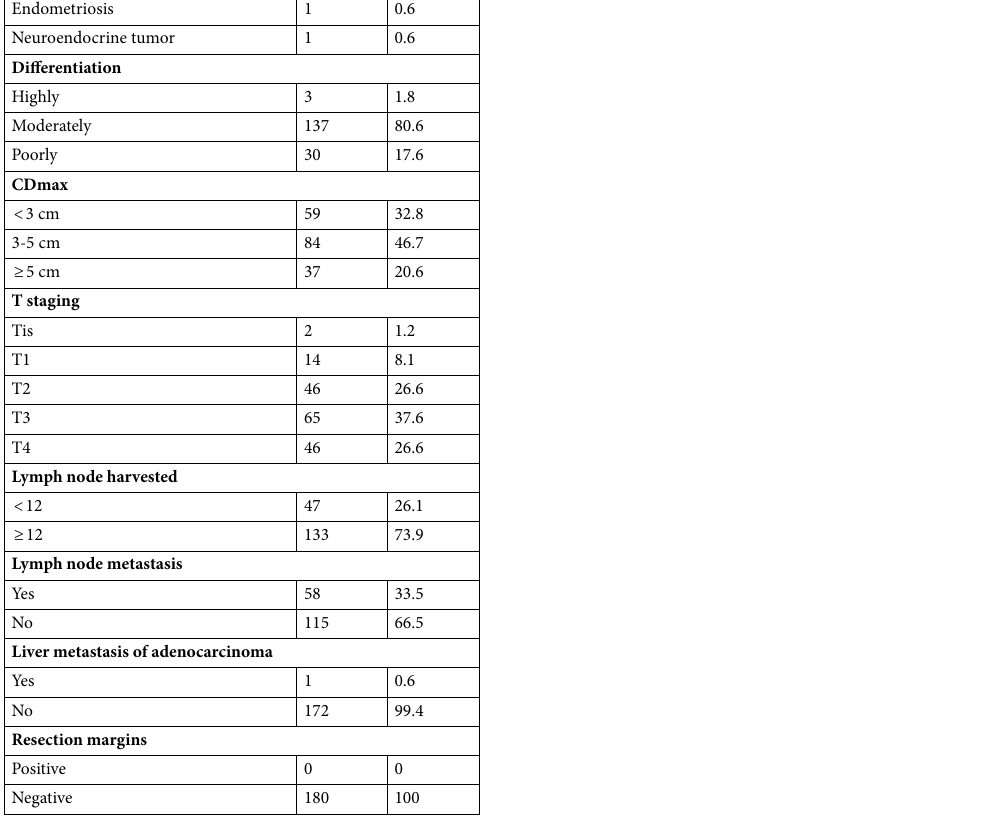
Table 2. Pathological